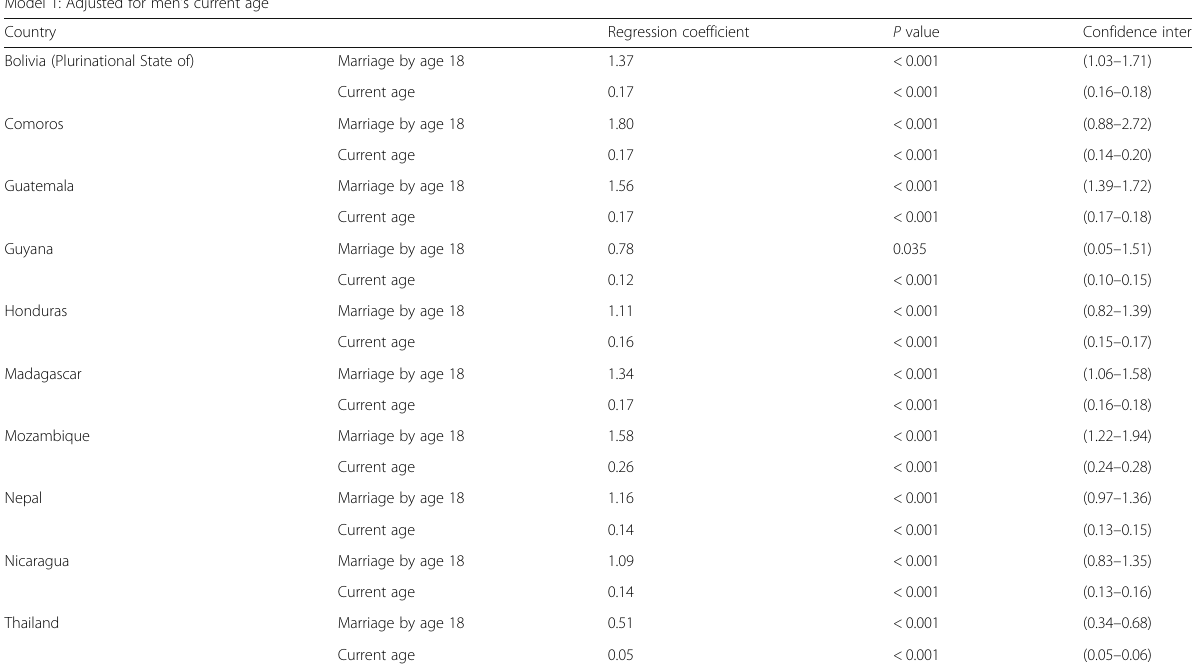
Table 11 Results from linear regression analysis: Factors associated with the number of children ever fathered among currently married men aged 20 – 49 Model 1: Adjusted for men ’ s current age